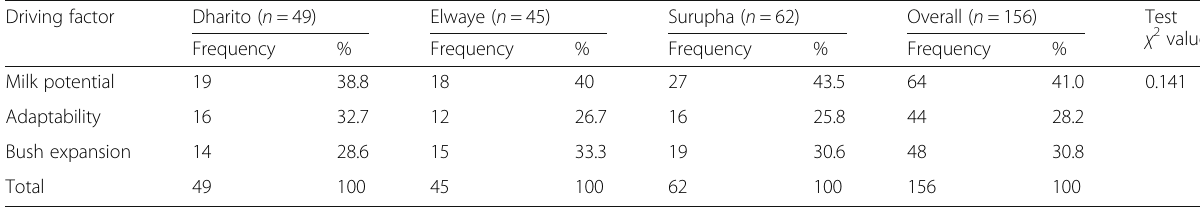
Table 3 Respondents ’ perceptions on driving factors for camel management as an adaptation strategy in the three kebeles in the study area in Borana, southern